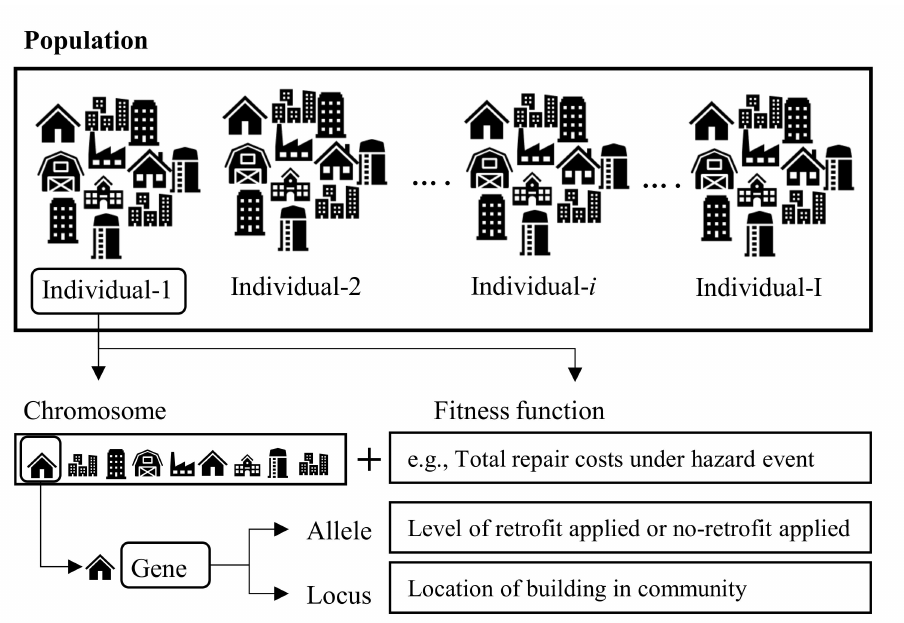
Figure 2. Evolutionary optimization terminologies in the context of community building